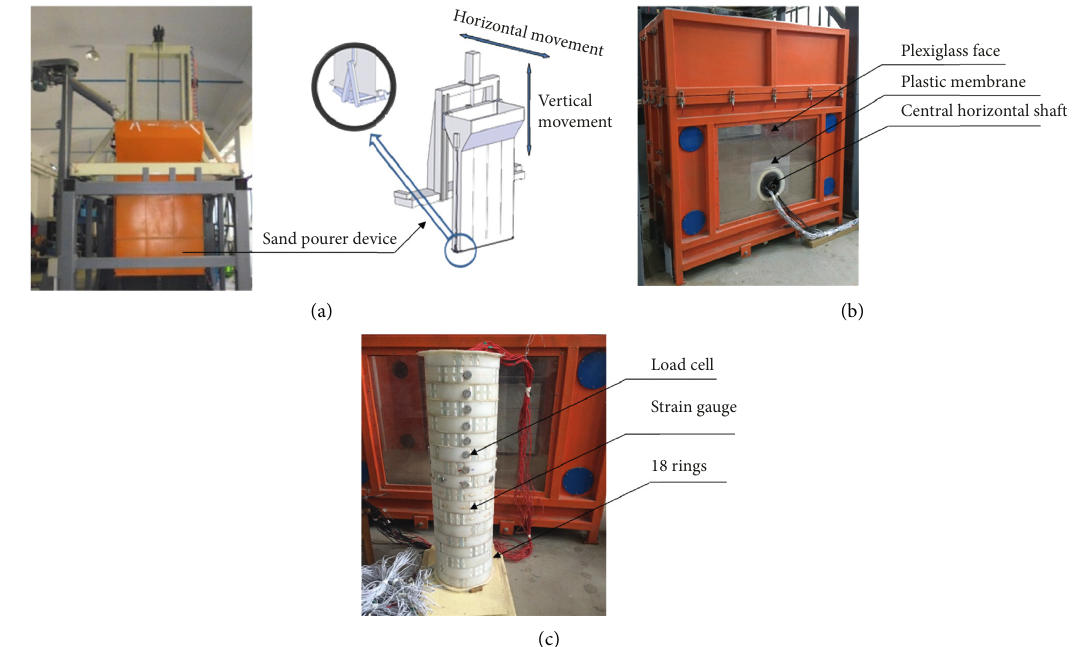
Figure 6: Testing devices. (a) Sand pourer device. (b) Strong box. (c) Model tunnel.